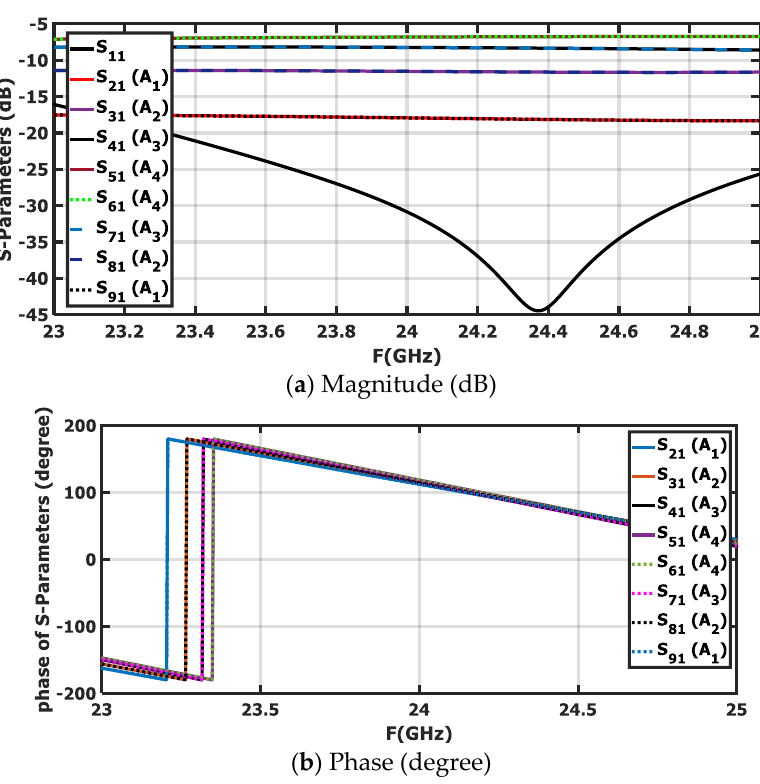
Figure 4. S-parameters of power dividers. Table 1. Power divider branches impedances (optimization values).